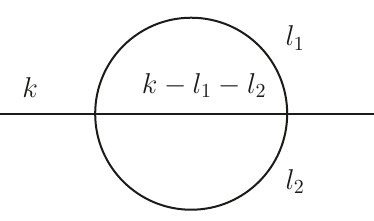
Figure 2 . The massless sunset diagram. 2 All momenta (cid:13)ow to the